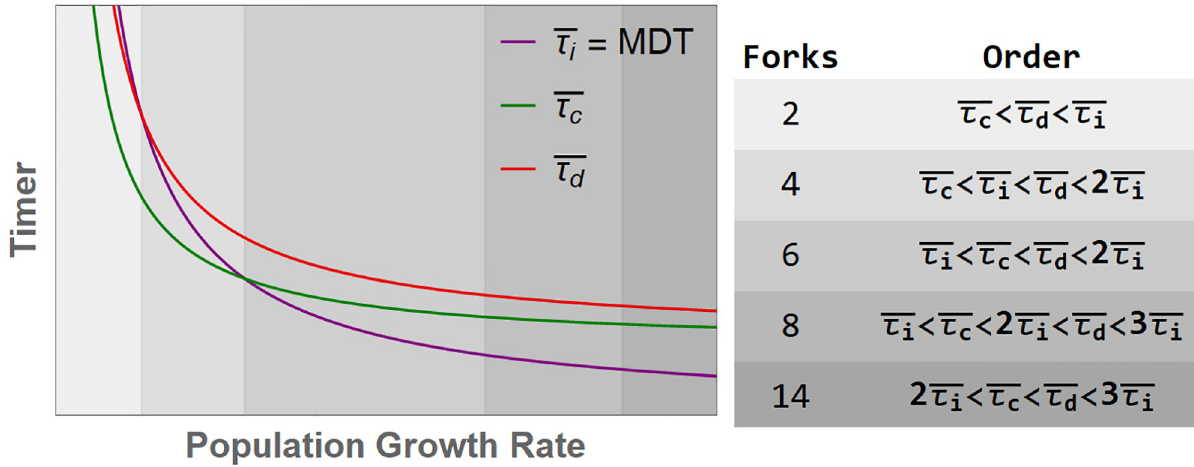
Fig 6. Determining dominant fork numbers from nutrient-imposed population growth rate. Our expectation for the trends in t (representing the population mean values related to the stochastic timers τ i , τ C , and τ d ) as a function of nutrient-imposed population growth rate. We and τ to flatten as growth rate goes to infinity, while mean τ expect mean τ C d population growth rates are determined by the relative order of these timers, as shown.